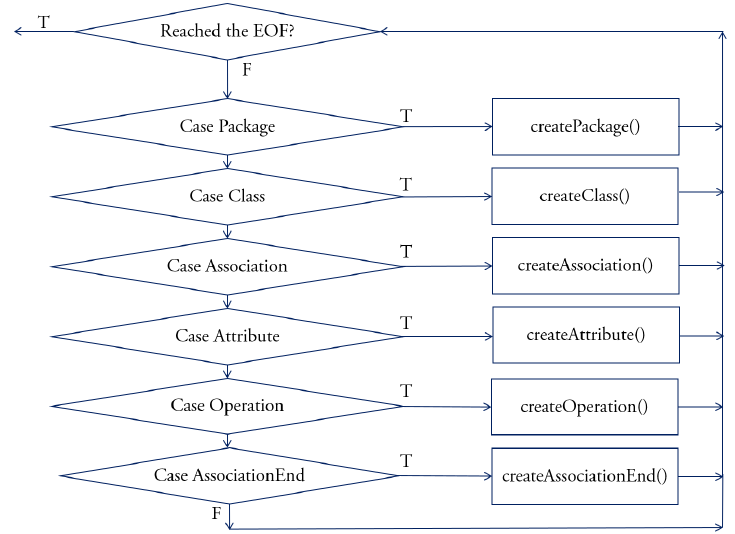
Figure 13. The processing of the tree-like structure. The flow chart reproduces the structure of the code (a “ switch ”) and uses the same names of the methods in it. For example, createClass() creates an instance of a Java object, initializes its fields by means of getters and setters with the metadata fetched from the attributes of the current node and adds such an object to the output list.